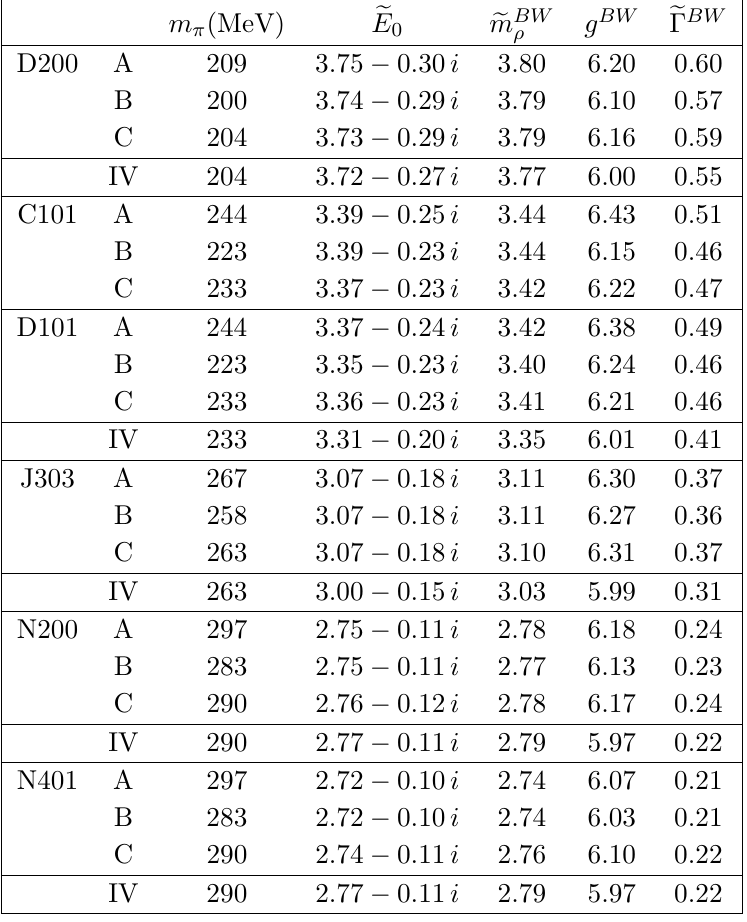
Table 8 . (cid:26) -meson pole positions and couplings obtained for the individual Tr M = C (cid:12)ts given in tables 6 and 7 and for each scale setting. The IAM pole position is denoted by E 0 , while the BW parameters m BW , g BW and (cid:0) BW are obtained by re(cid:12)tting the IAM solution to the (cid:26)